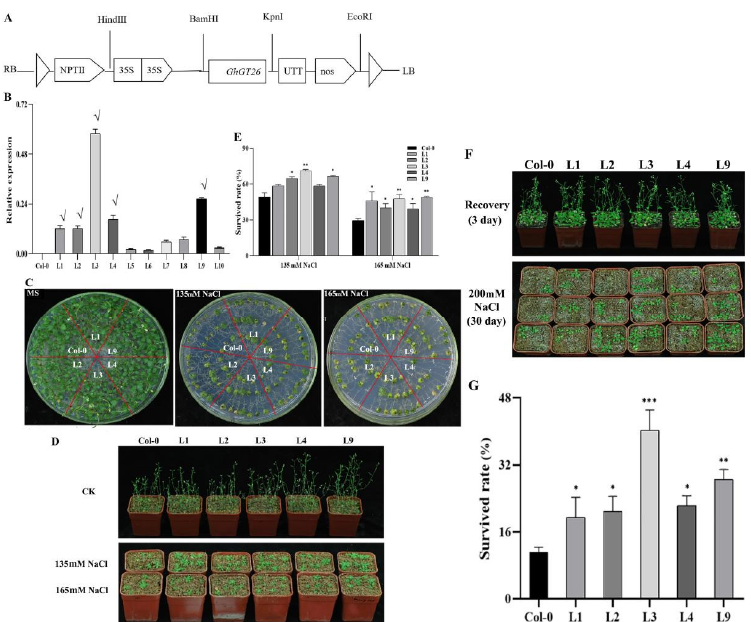
Figure 3. Performance of GhGT26 -transgenic seedlings under salt treatment. ( A ) Construction of the GhGT26 gene expression vector. ( B ) The evaluation of the expression level of the GhGT26 gene in transgenic Arabidopsis plants. √ indicates the transgenic lines with high expression levels for phenotypic analysis. ( C ) Growth of the transgenic and wild type (Col-0) under 135 and 165 mM NaCl treatments. ( D ) Recovery of salt treatment transgenic and wild type plants in pots. ( E ) Survival rates of transgenic and wild type plants in ( D ). ( F ) Growth of the transgenic and wild type (Col-0) under normal and in the pot containing NaCl. ( G ) Survival rates of transgenic and wild type plants in ( F ). Error bars indicate SD, and asterisks indicate a significant difference (* p < 0.05; ** p < 0.01; *** p < 0.001).